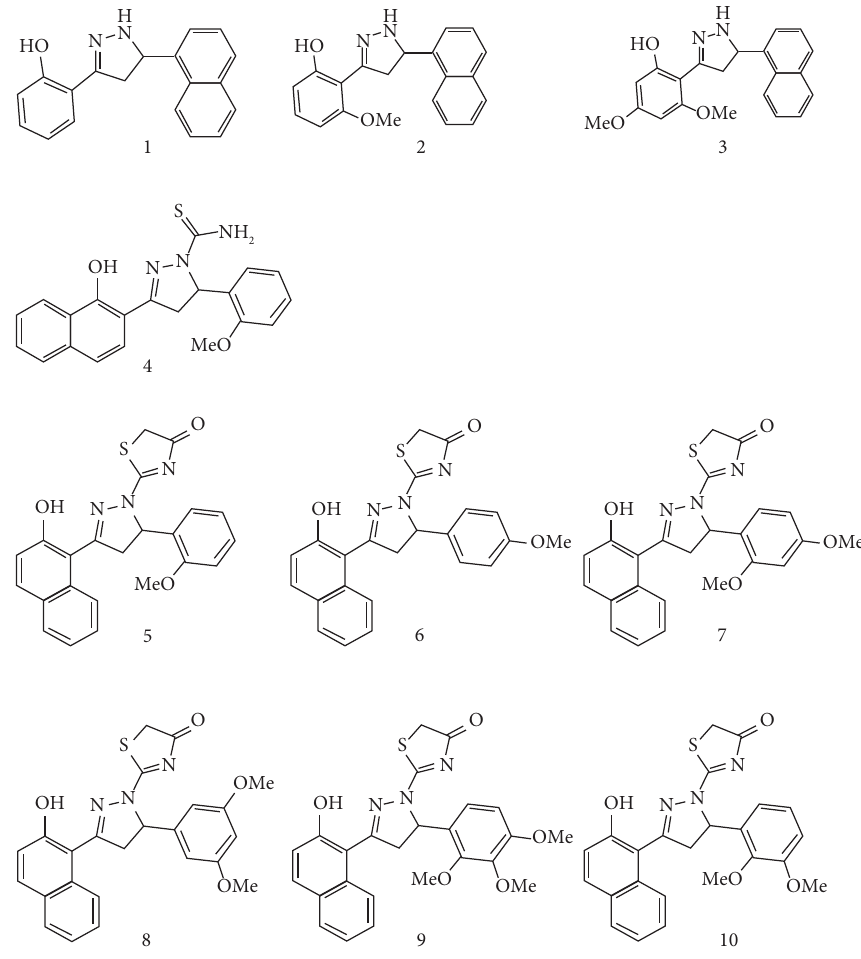
Figure 2: Structures of ten